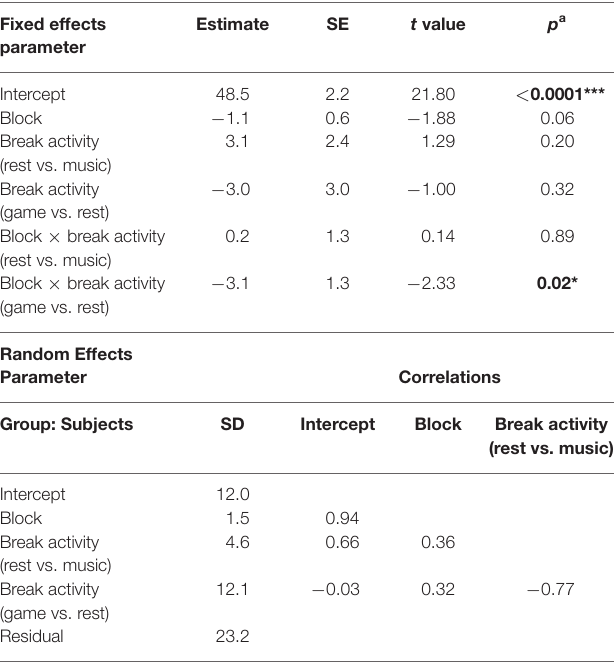
TABLE 2 | Model parameters of target sensitivity in the 3-back